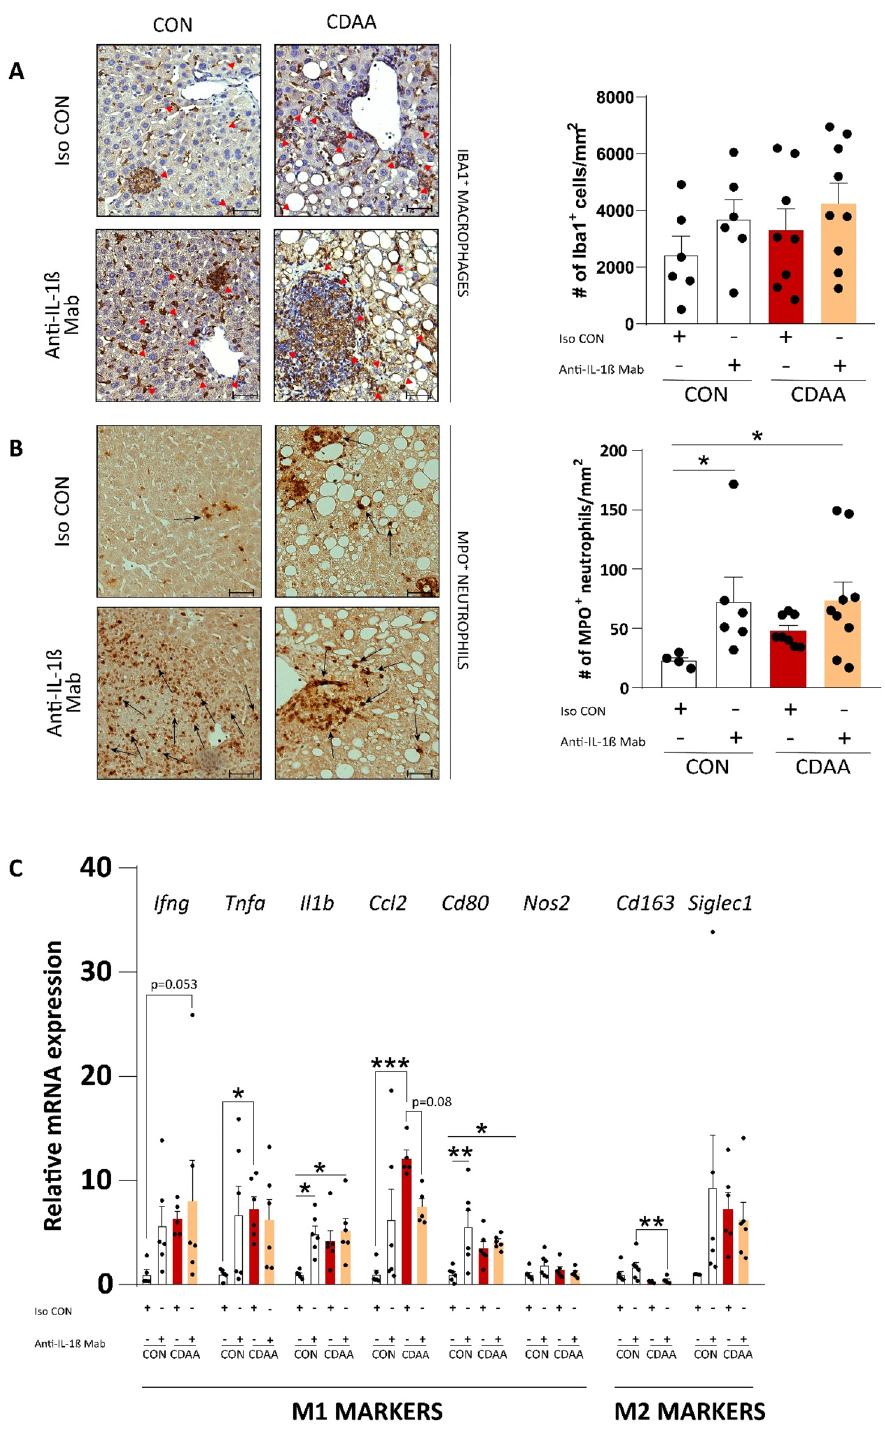
Figure 4. Hepatic macrophage and neutrophil infiltration. Immunohistochemical assessment and quantification of hepatic Iba1 + macrophages ( A ) (n = 6–9/group) and MPO + neutrophils ( B ) (n = 4–9/group). Red and black arrows show the corresponding immune cells. qRT-PCR assessment of major M1 and M2 markers ( C ) (n = 5–6/group). CDAA, Choline Deficient L-Amino Acid-defined diet; CON, control diet; Iso CON, isotype control; Anti-IL-1β, anti-interleukin-1β monoclonal antibody, Iba1; ionized calcium-binding adapter molecule 1; MPO, myeloperoxidase. Scale bar shows 100 µm. Two-way ANOVA, Fisher’s LSD post hoc test, * P < 0.05, ** P < 0.01, *** P <